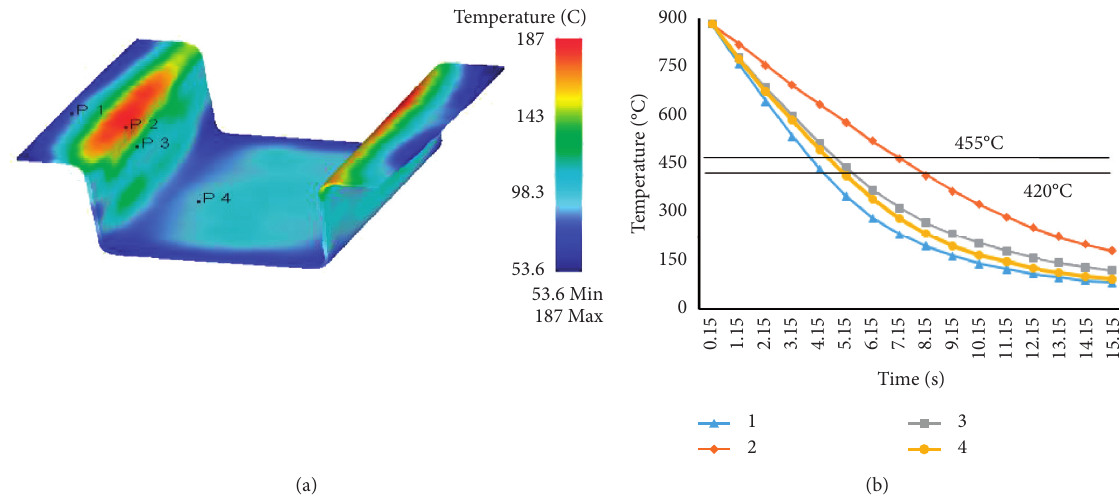
Figure 8: Temperature distribution of the formed part and change rule of reference points’ temperature during the synchronous quenching process in individual production.